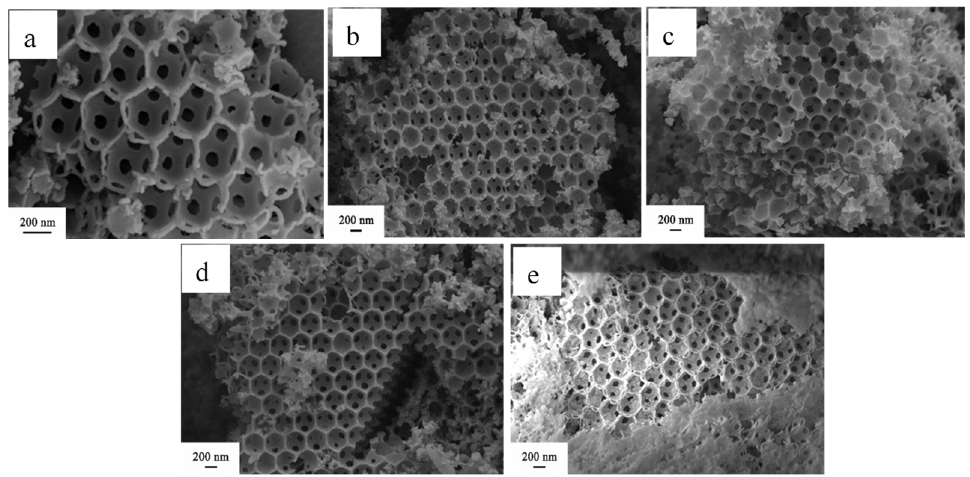
Figure 2. SEM images of the catalysts ( a : M-TSO; b : MnCeO x /M-TSO; c : K 0.1 MnCeO x /M-TSO; d : K 0.5 MnCeO x /M-TSO; e : K 1 MnCeO x /M-TSO).